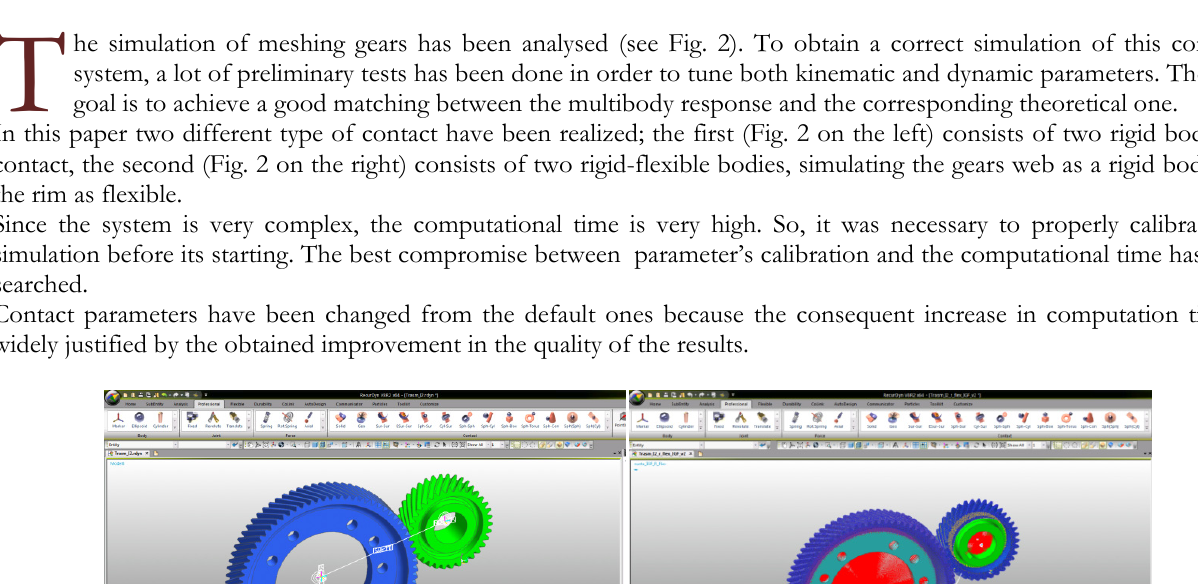
M ULTIBODY M ODEL